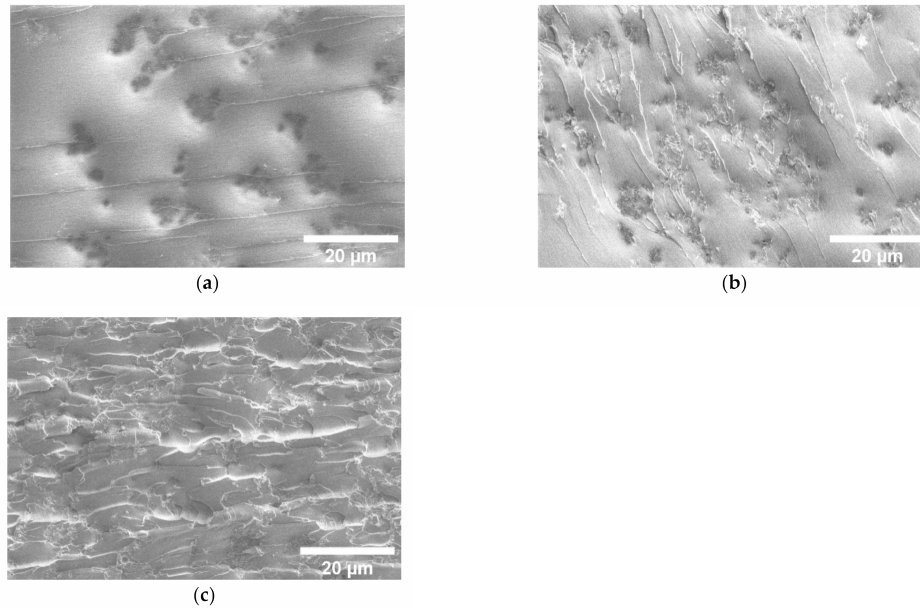
Figure 4. Panoramic scanning electron microscopy micrographs of hybrid Ni@C/MWCNTs/epoxy resin composites with 0.09 vol.% of MWCNTs and ( a ) 0, ( b ) 0.6 and ( c ) 1 vol.% of